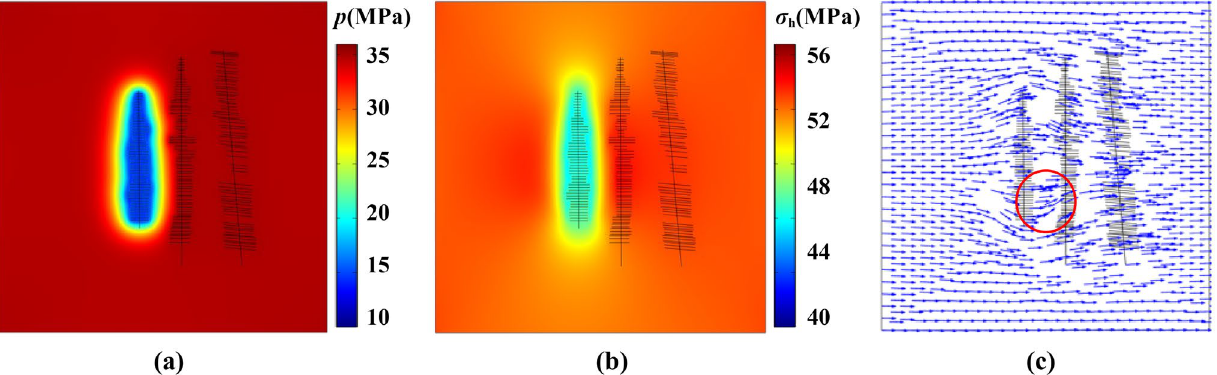
Fig. 6 Pressure and stress fields after the phase one production: a formation pressure p ; b minimum horizontal stress; c orientation of maximum horizontal stress σ